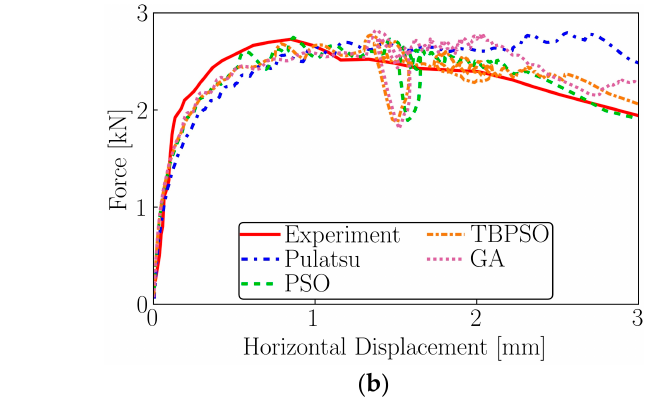
Figure 18. Calibrated material parameter load displacement diagrams of Pulatsu’s geometry (objective function 2, PSO and GA: 50 iterations; TBPSO: 20 iterations): ( a ) vertical displacement, ( b ) horizontal displacement.